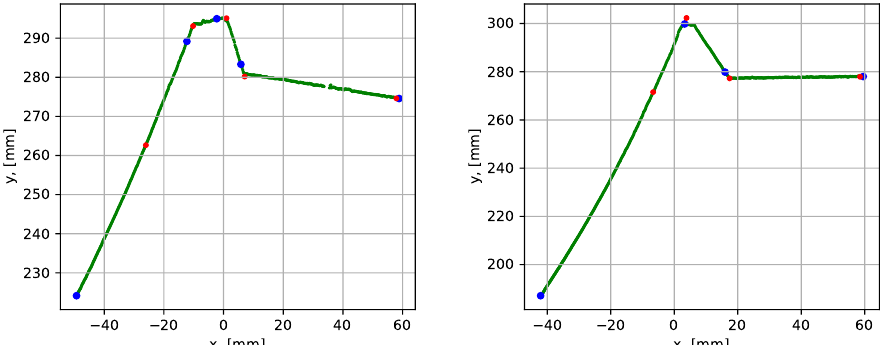
Figure 20. Parametrization results with groove corner points for dataset 2 (to the left) and 3 (to the right), when the correction of assigned corners step is omitted. The blue dots show the result before the iterative error elimination procedure and the red dots show